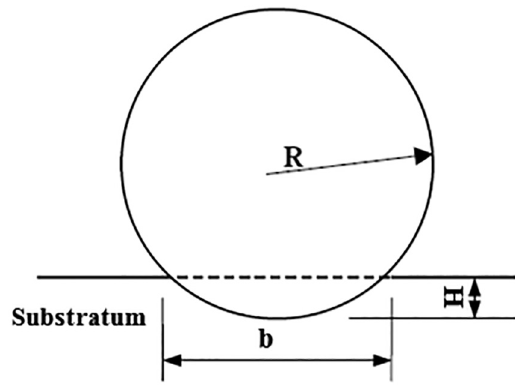
Figure 3: SEM micrograph of F-53 steel; Beraha reagent was used for chemical